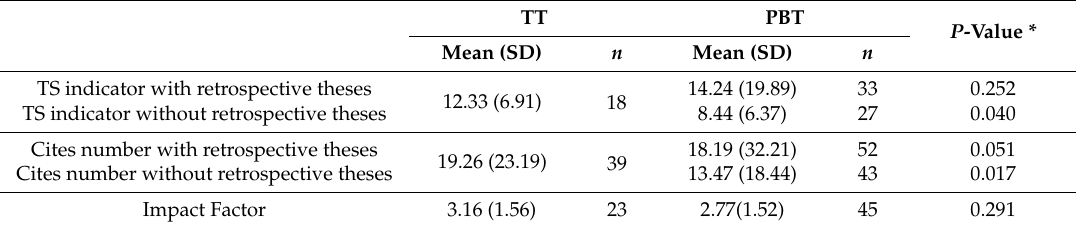
Table 3. Aspects regarding thesis-related articles from traditional and publication-based